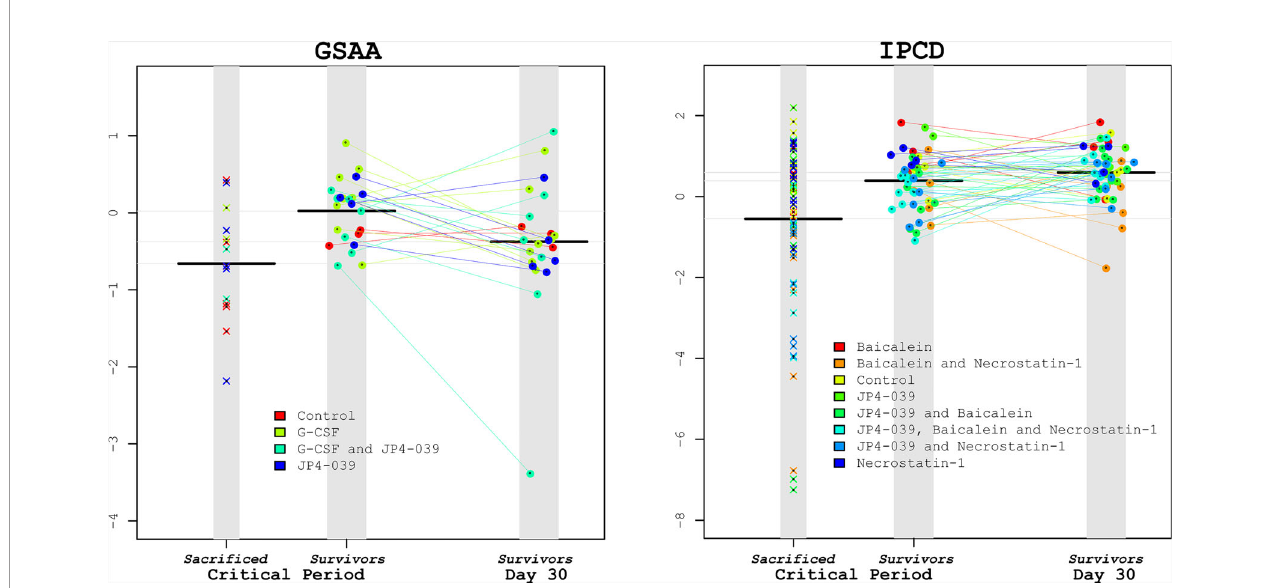
FIGURE 6 | Lactobacillus levels comparing Sacri fi ced vs. Survivors. To visually illustrate the results from the survival analysis, Lactobacillus levels during the critical period were compared between the sacri fi ced vs. the surviving mice for the GSAA and IPCD experiments (left and right plots, respectively). Within each plot there are 3 columns: The left-most columns depict the average Lactobacillus levels from the samples available for the mice during the critical period that were eventually sacri fi ced. The center column depicts the Lactobacillus levels during the critical period for eventual surviving mice, connected with lines to the Lactobacillus levels on day 30 in the right-most column. The black horizontal bars represent the median Lactobacillus levels for each column. From these plots it can be con fi rmed that the median Lactobacillus levels of the sacri fi ced mice were lower than the survivors during the critical period for both experiments. The Lactobacillus levels of the eventual survivors were not signi fi cantly different between this critical period and at Day 30. These scatter plots illustrate the wide variance of the Lactobacillus levels in the sacri fi ced mice, suggesting that an intervention of supplemental Lactobacillus by itself may have limited bene fi